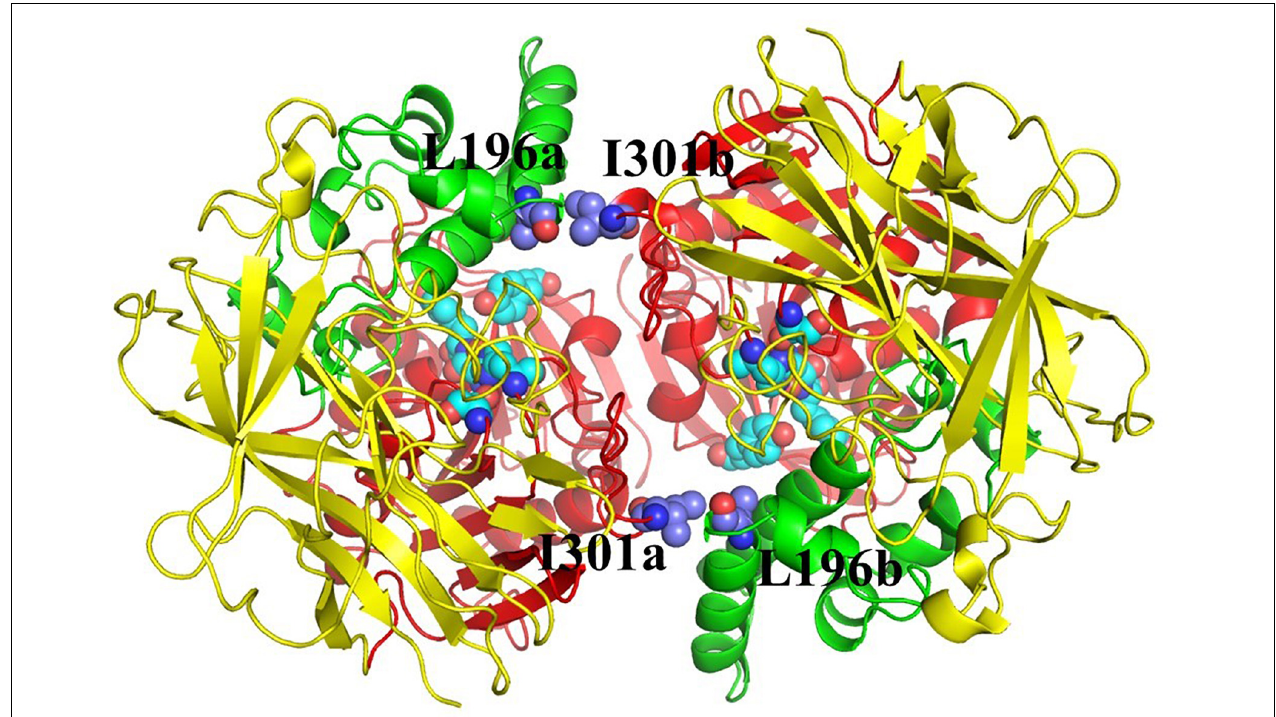
FIGURE 1 | Crystal structure of the cocaine esterase (CocE) dimer. Ribbon representation of the homodimeric molecule showing the side chains of the soleucine and leucine residues that will be replaced with cysteine forming intersubunit disulfide